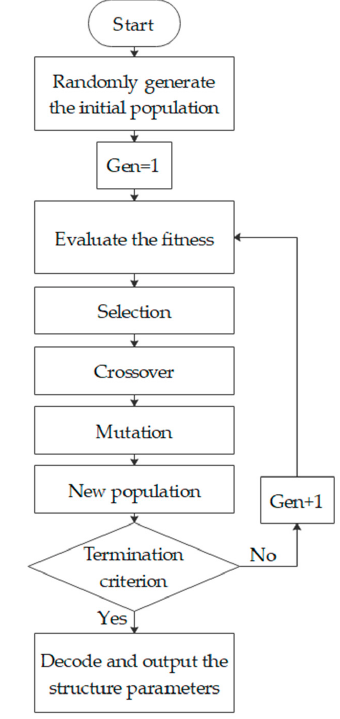
Figure 6. Flowchart of the genetic algorithm (GA) process.